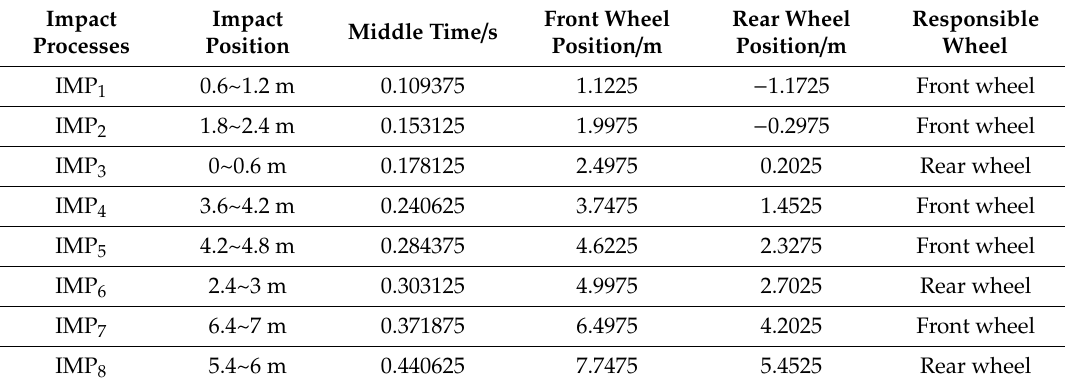
Table 2. Results of the recognition and positioning algorithm.